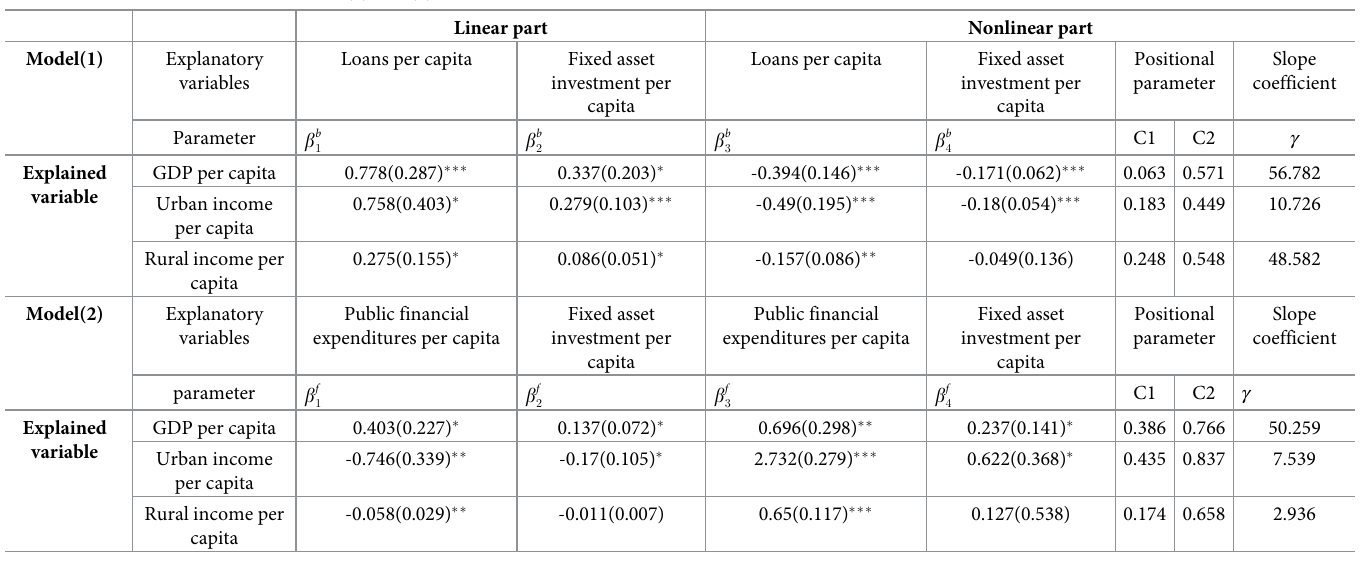
Table 7. Estimation of nonlinear models (1) and (2).